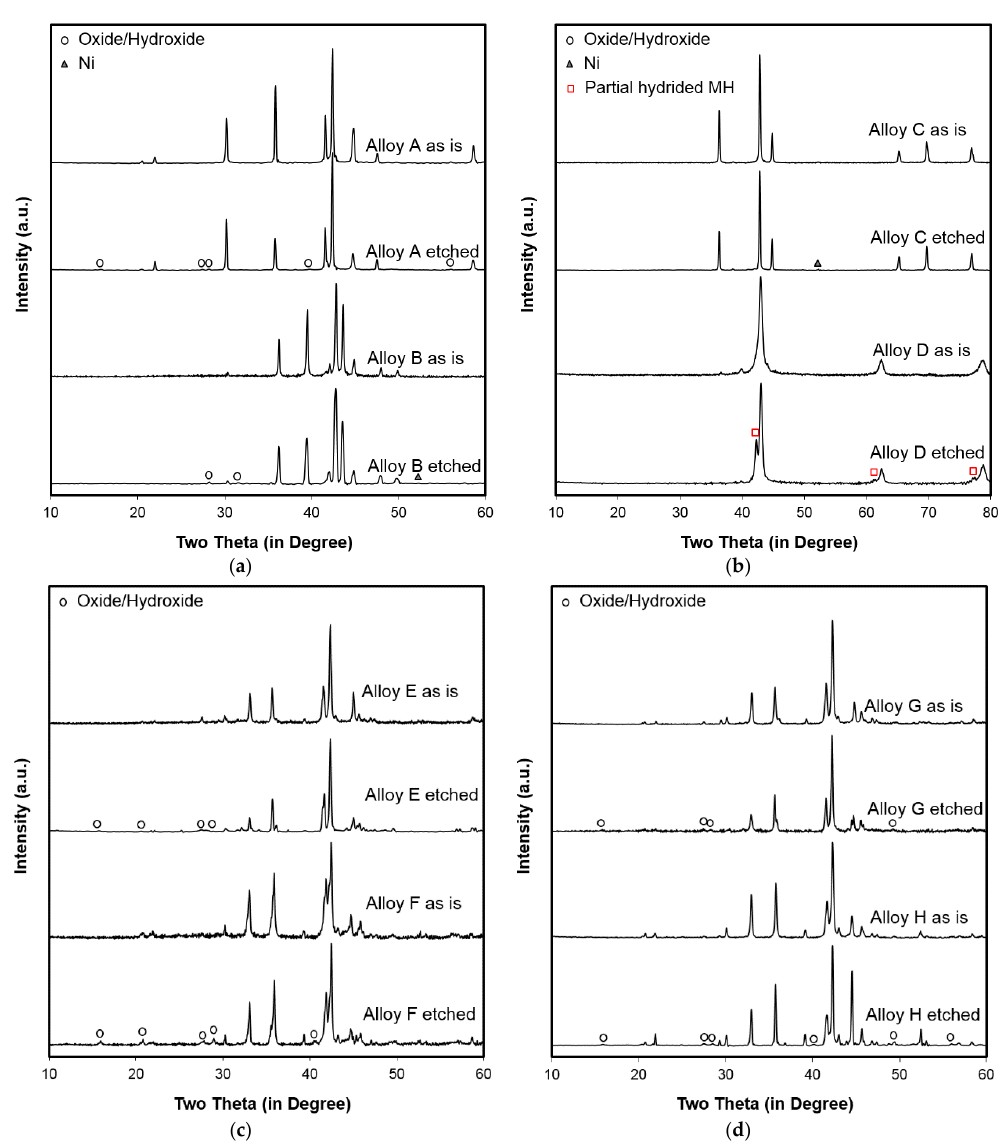
Figure 10. X-ray diffractometer (XRD) patterns using Cu-K α as the radiation source for alloys ( a ) A , B , ( b ) C , D , ( c ) E , F and ( d ) G , H before and after KOH-etching.